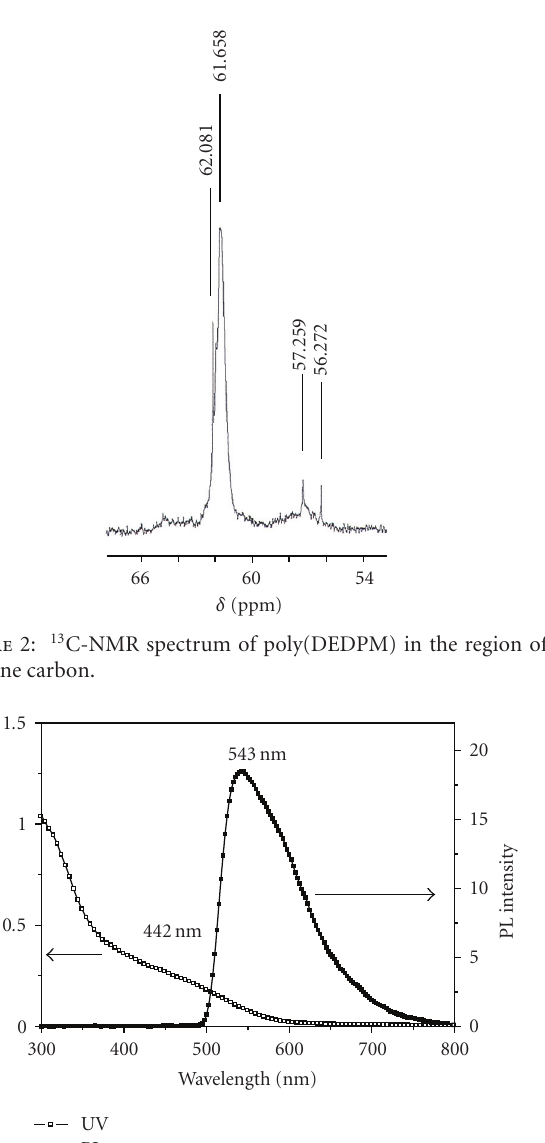
Figure 4: Cyclic voltammograms of poly(DEDPM) [0.1M ( n - Bu) 4 NBF 4 /DMF] (a) consecutive 30 scans under 100 mV/s and (b) 30 mV/sec ∼ 120 mV/sec with various scan